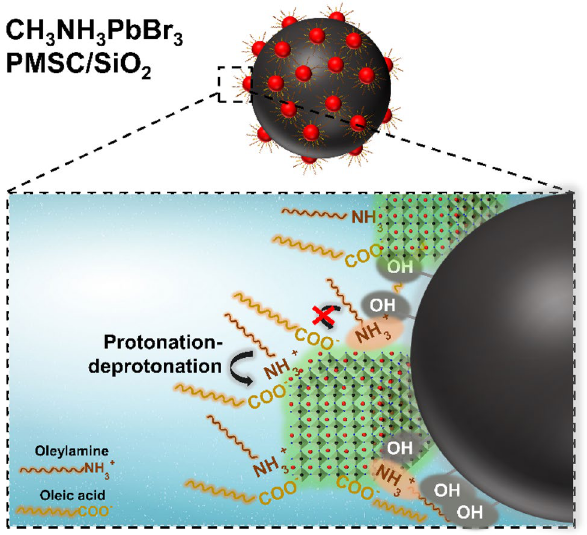
Figure 6. Illustration of the surface passivation of the CH 3 NH 3 PbBr 3 PMSCs by SiO 2 and oleylamine and oleic acid